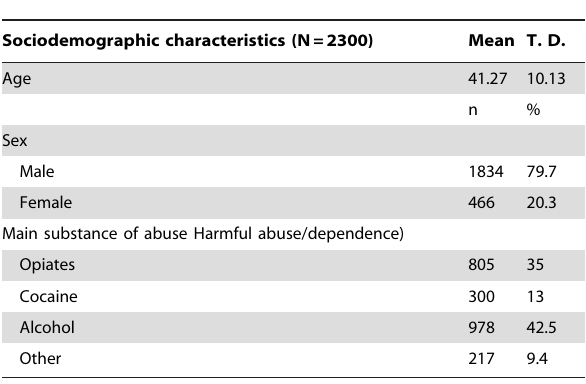
Table 1. Sociodemographic characteristics and main substance of abuse.